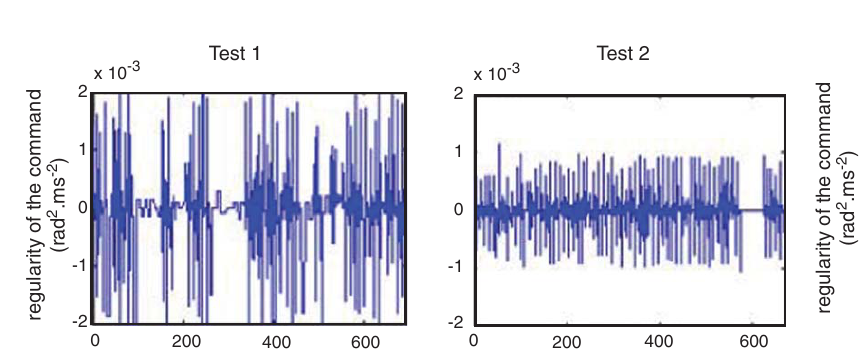
Fig. 12. Charge of command for the two tests.